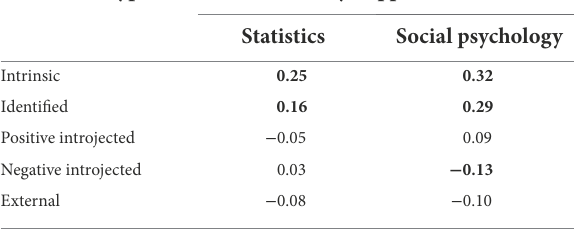
TABLE 5 Correlations between autonomy-supportive climate and motivation types in corresponding courses ( n = 294). Motivation type